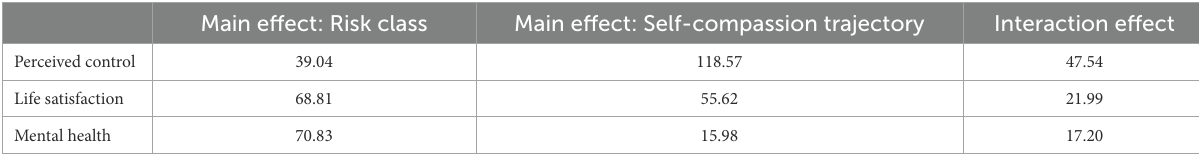
TABLE 7 Wald χ 2 tests for all main and interaction effects. Main effect: Risk class Main effect: Self-compassion trajectory